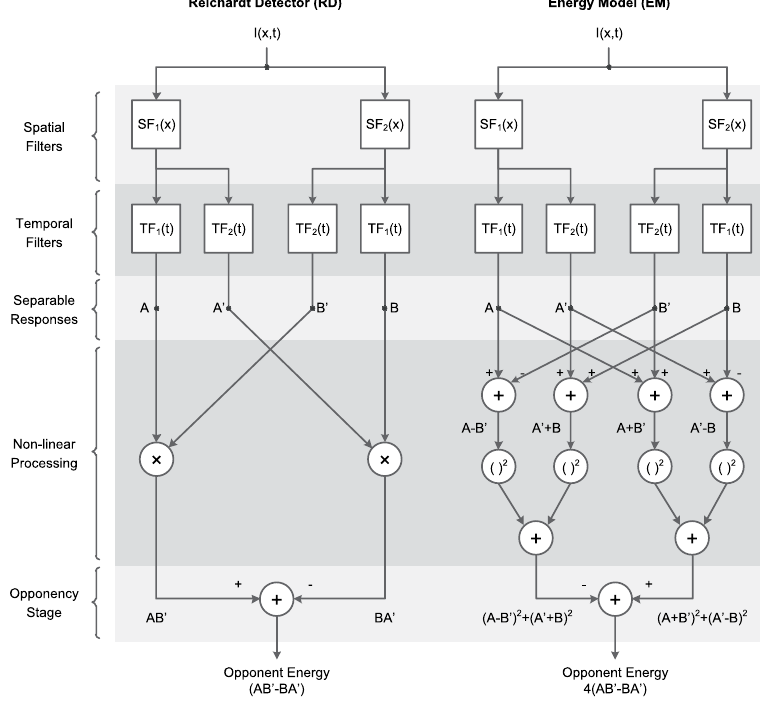
Figure 1. Opponent energy models of motion detection. The Reichardt Detector (RD) and the Energy Model (EM) are two prominent opponent models in the literature of insect and mammalian motion detection. The two models are formally equivalent when the spatial and temporal filters are separable (as shown) and so their outputs and response properties are identical even though their structures are different. Both models use the outputs of several linear spatial and temporal filters ( SF 1 , SF 2 , TF 1 and TF 2 ) to calculate two opponent terms and then subtract them to obtain a direction-sensitive measure of motion (opponent energy). Nonlinear